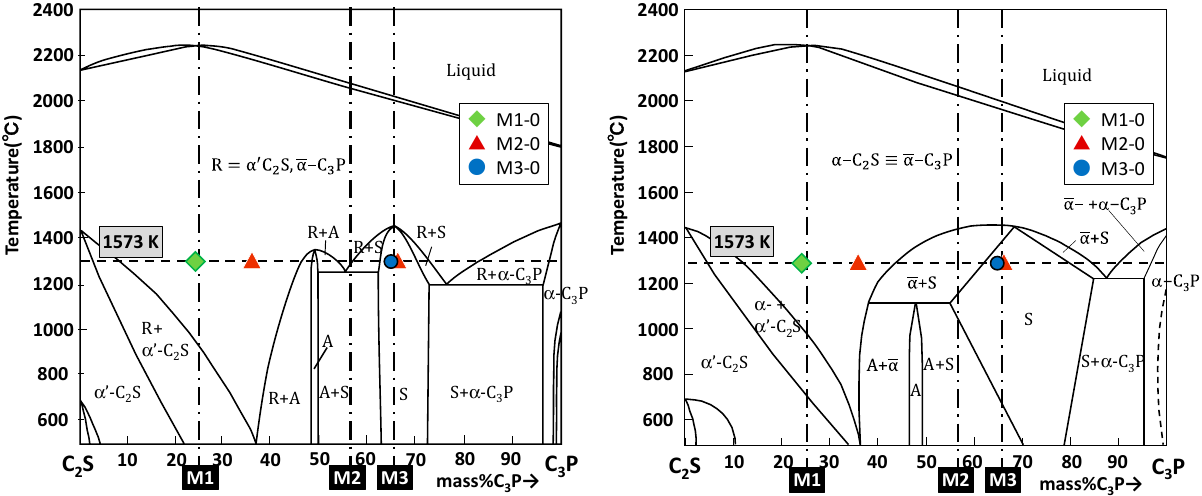
Figure 12. C 2 S-C 3 P pseudo-binary phase diagram after Fix ( left ) [31] and Nurse ( right ) [30]. The compositions of C 2 S-C 3 Pss phases observed in the ternary samples are also plotted.